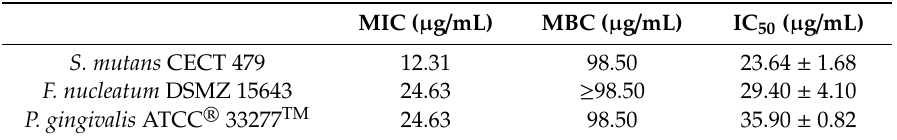
Table 1. Minimum inhibitory concentration (MIC), Minimum bactericidal concentration (MBC), and the half-maximal inhibitory concentration (IC 50 ) values (μg/mL, Ag concentration) of GSH-AgNPs nanoparticles against the oral bacteria studied.